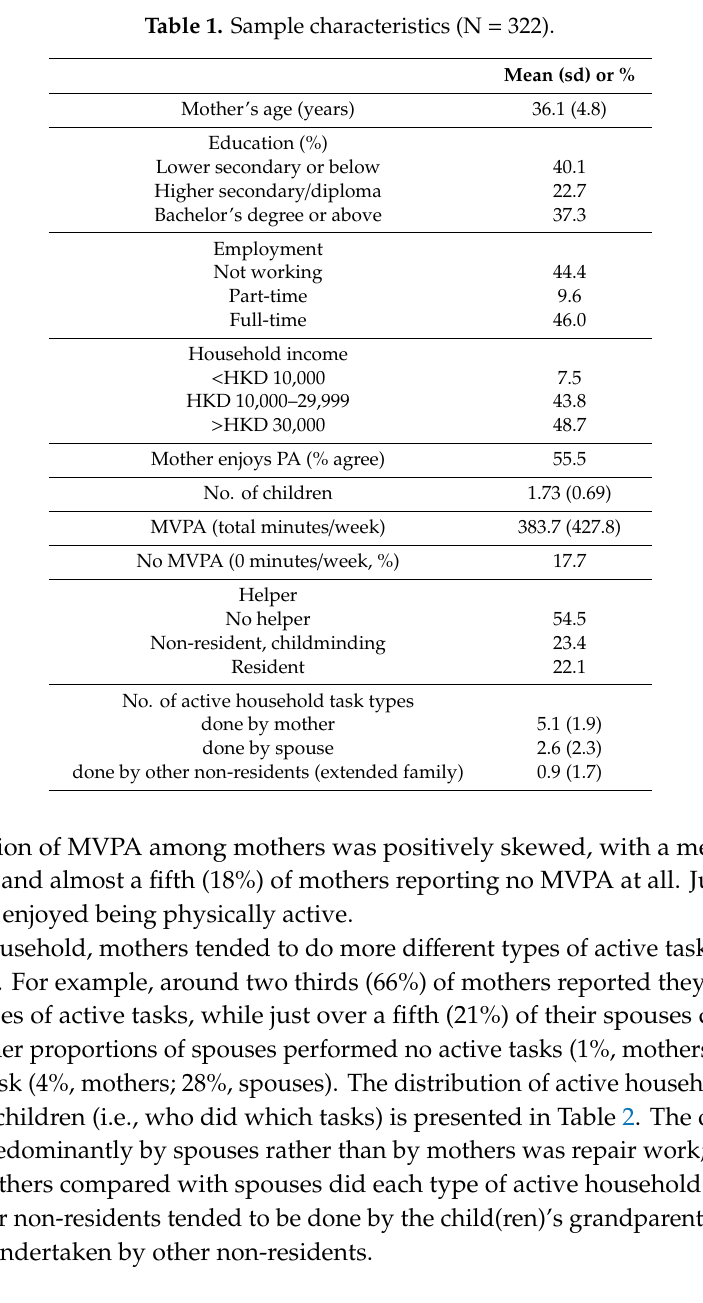
Table 2. Division of housework in